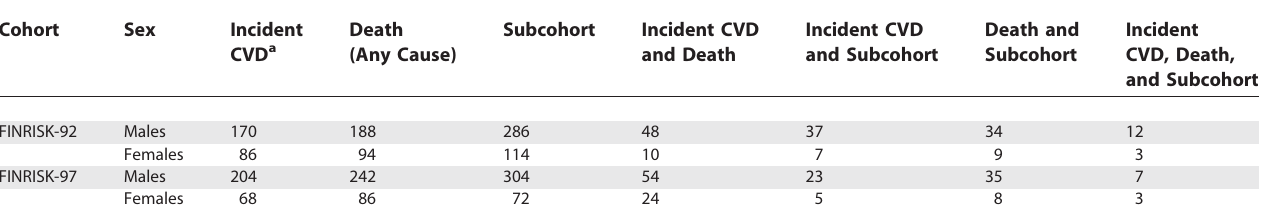
Table 1. Numbers of Study Subjects in the Random Subcohort and with Different Endpoint Events in FINRISK-92 and FINRISK-97 Cohorts Cohort